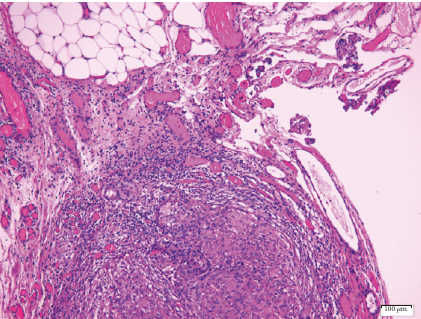
Figure 1: Omental adipose tissue containing a sarcoid-type granu- loma (Hematoxylin and Eosin, × 10).